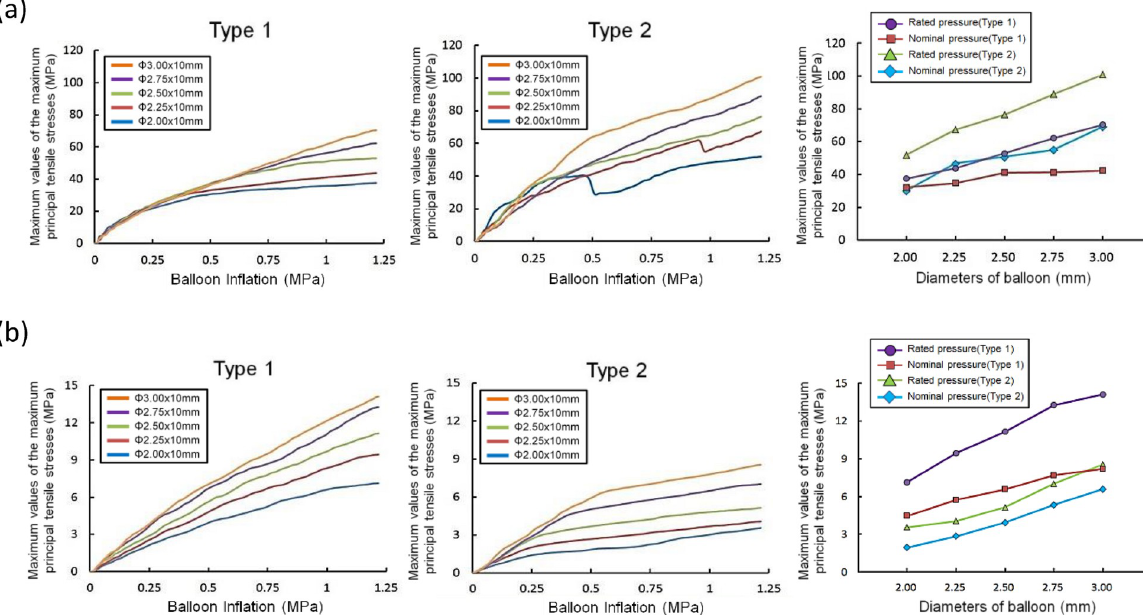
Fig 6. Effects of cutting balloon diameter and blade direction on the maximum principal tensile stresses in the models of the calcification and artery adjacent to the calcification. (a) Maximum principal tensile stresses in the calcification model for Type 1 and Type 2 for five different balloon diameters. (b) Maximum principal tensile stresses in the artery model adjacent to the calcification for Type 1 and Type 2 for five different balloon diameters.